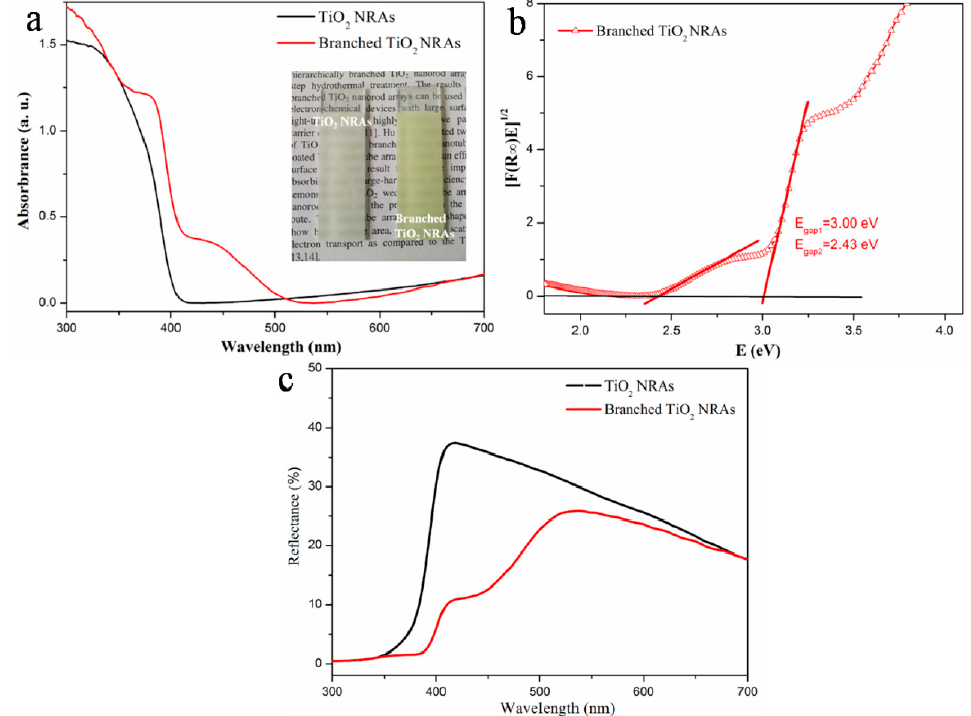
Figure 5. ( a ) Diffuse reflection absorption spectra, with an inset displaying the photo images of TiO 2 NRAs and branched NRAs; ( b ) transformed diffuse reflection absorption spectra of the branched NRAs and ( c ) diffuse reflection spectra of the TiO 2 NRAs and branched NRAs.